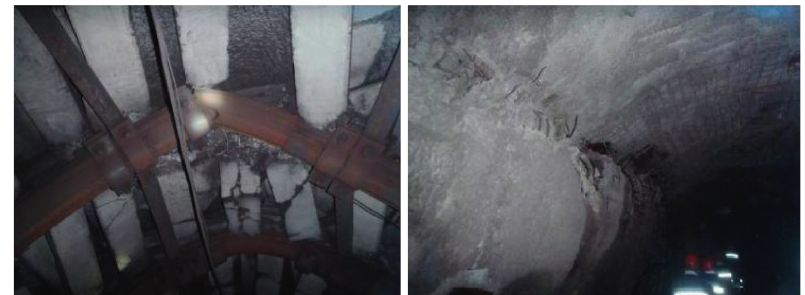
Figure 3: Deformation of the main roadway.